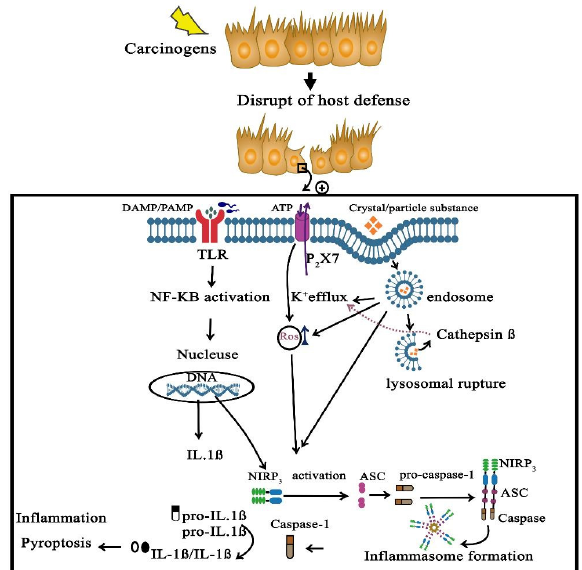
Figure 1. Inflammation-induced intestinal carcinogenesis through the activation of the NLRP3 in- flammasome. Carcinogens can disrupt the host defense through an increase in ROS/RNS production